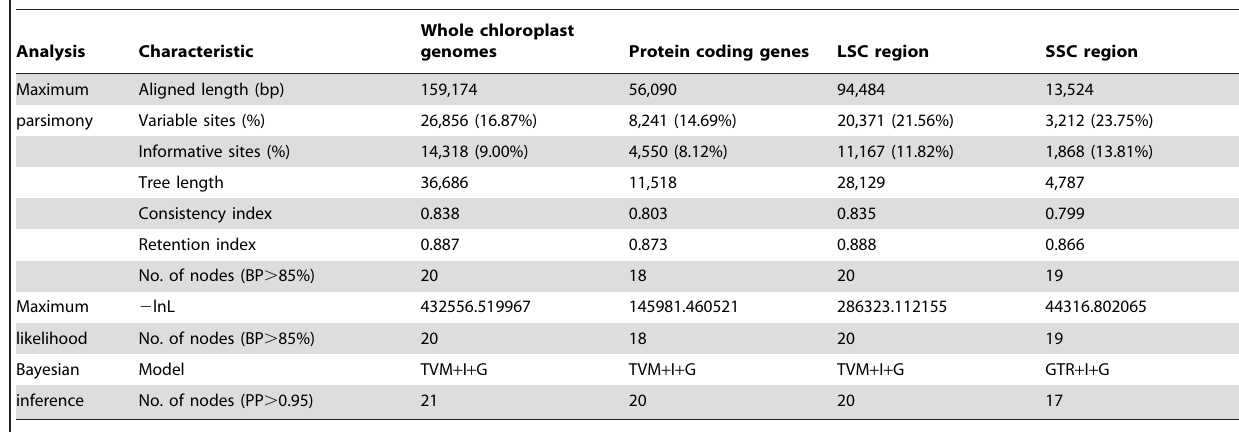
Table 2. Statistics of four data partitions used in phylogenomic analyses.